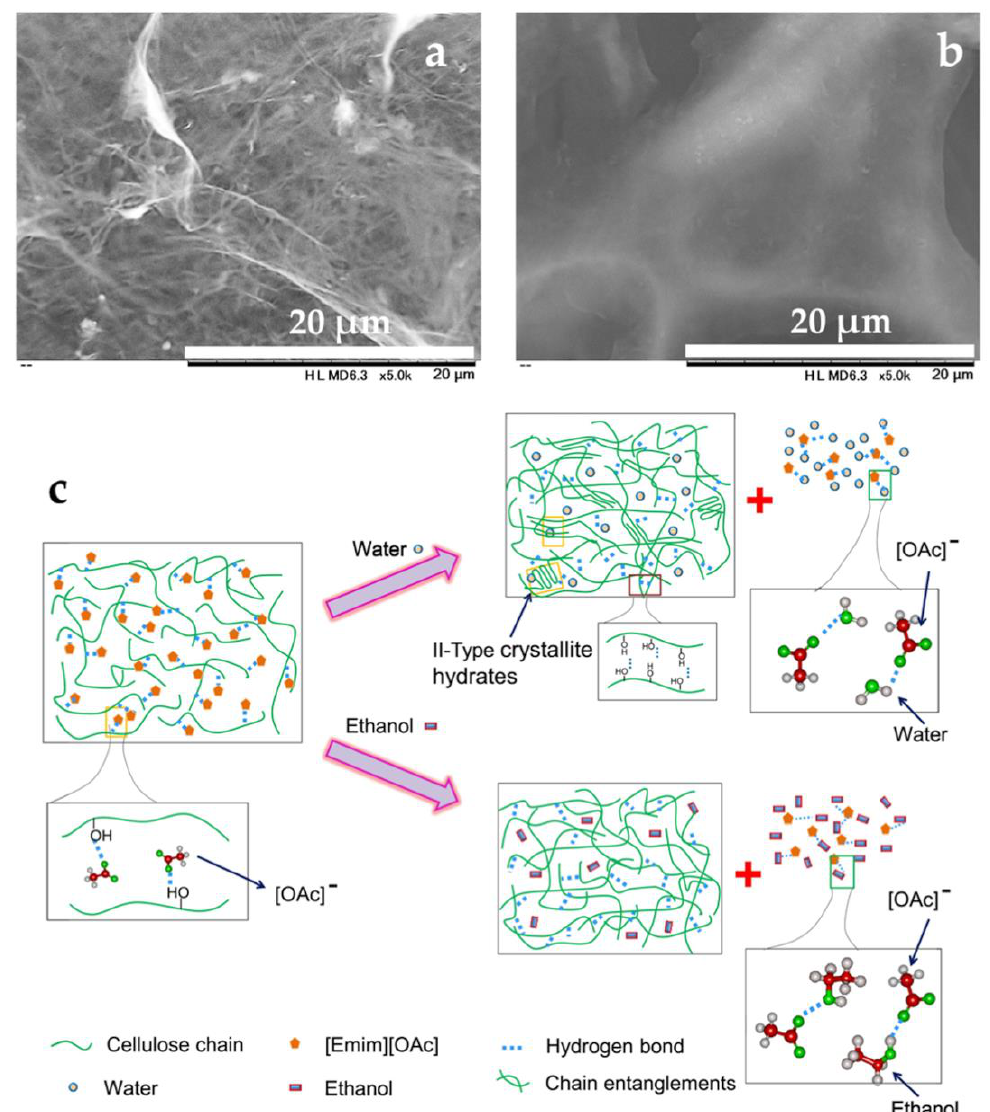
Figure 1. Cryo-SEM images of native bacterial nanocellulose pellicles ( a ) and cellulose hydrogel after dissolution in 1-ethylpyridinium chloride IL and regeneration in water ( b ) (authors’ own work). Schematic representation of the regeneration of cellulose in water and alcohol ( c ) (reprinted with permission from [24]. Copyright © 2019, Elsevier).